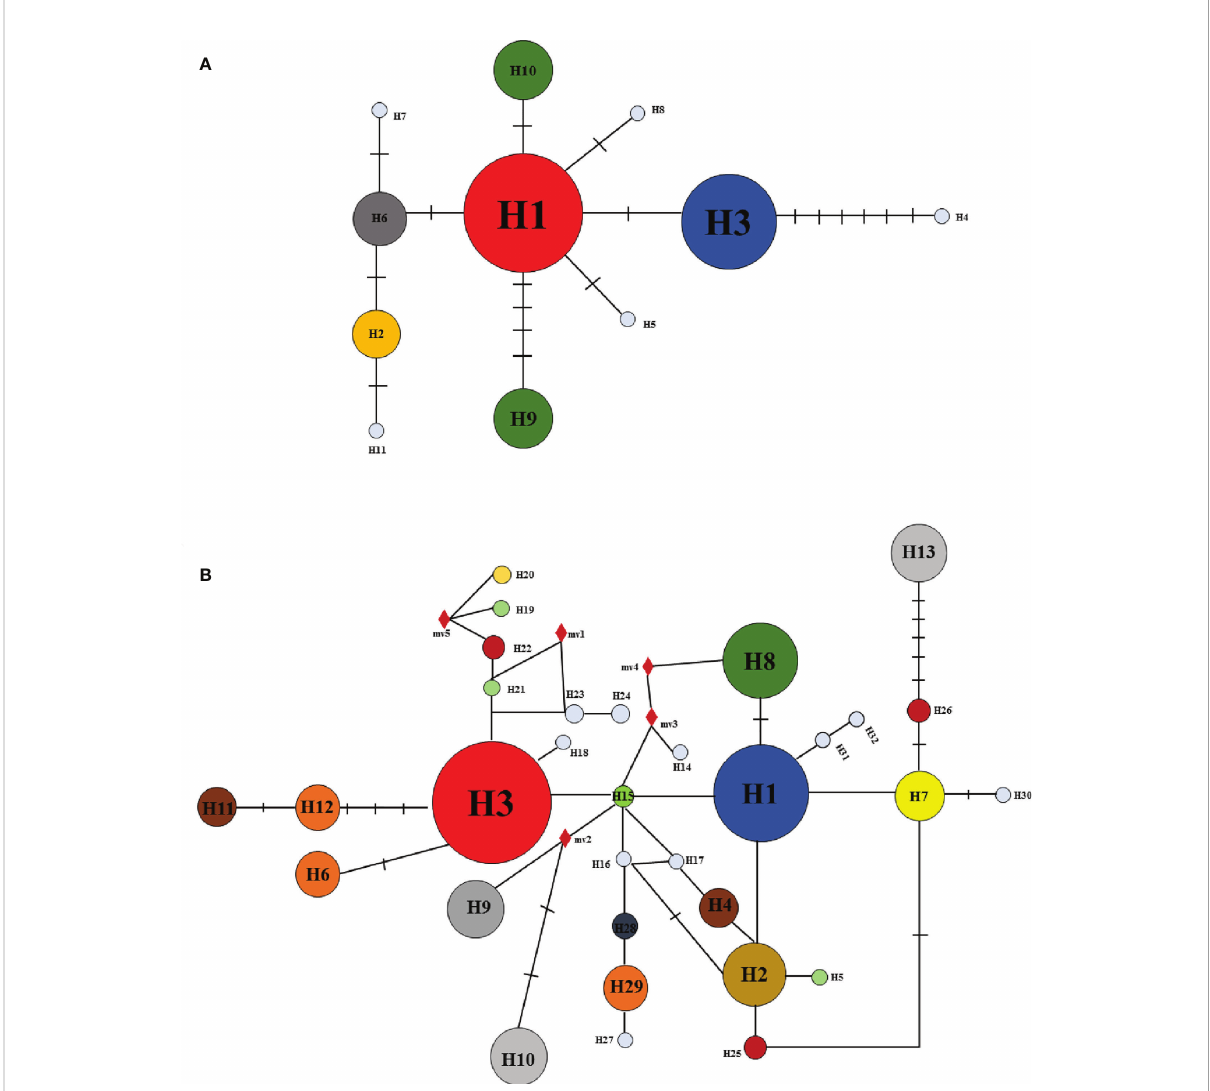
FIGURE 3 Haplotype relationships based on cpDNA (A) and nrDNA (B) by the median-joining